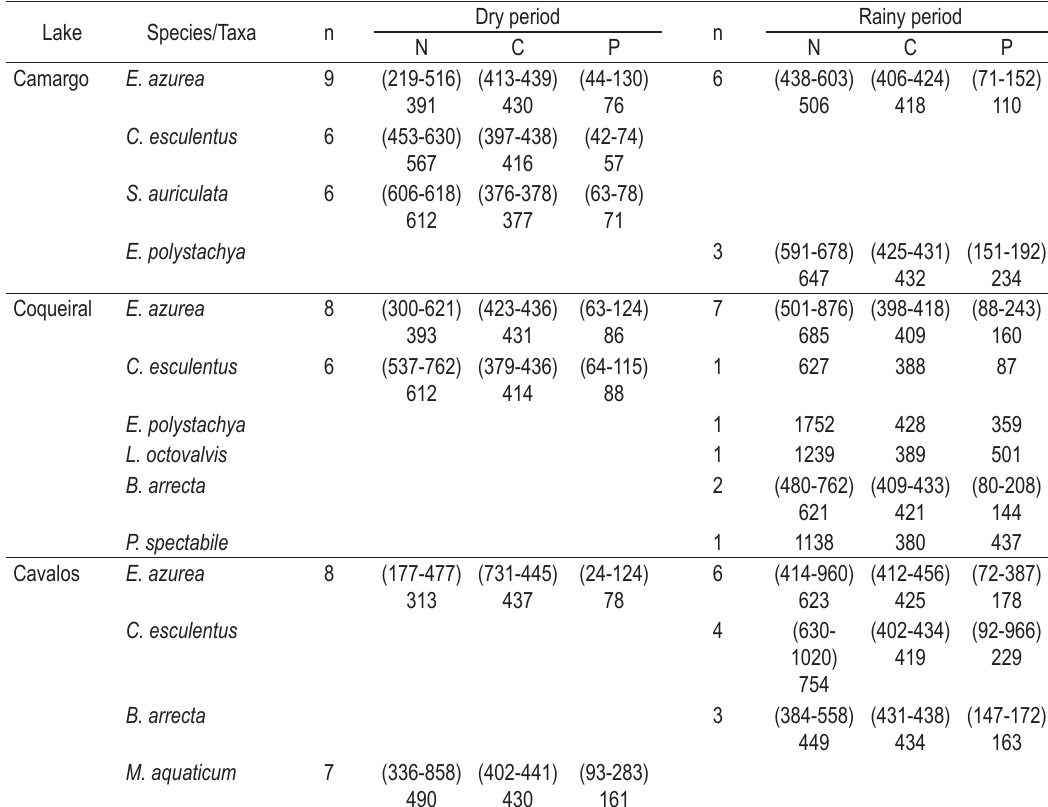
Table 3. Ranges (between parentheses) and means of nitrogen (N), carbon (C), and phosphorus (P) contents (mg.gDW -1 ) of aquatic macrophytes sampled in Camargo, Coqueiral, and Cavalos Lakes in dry and rainy periods (n = number of sampled